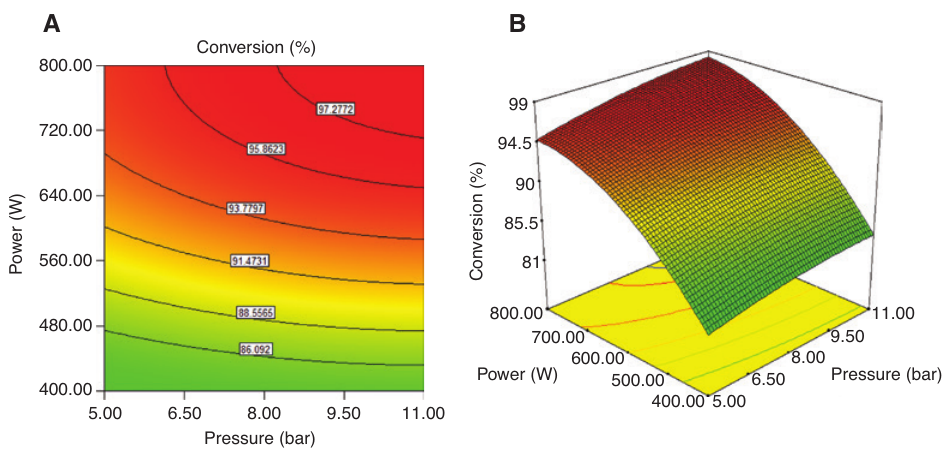
Figure 5: (A) 2D and (B) 3D interaction effect of MW power and pressure on FAME conversion.